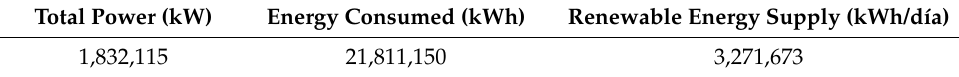
Table 12. Renewable energy